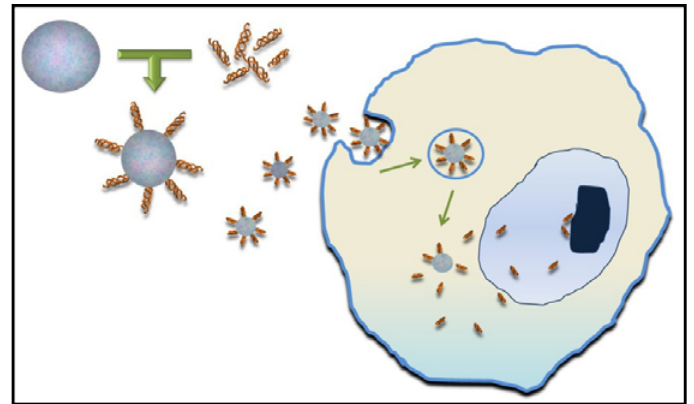
Figure 4. Synthetic nanoparticles are able to conjugate peptides, growth factors, nitric oxide or other molecules onto the particle surface and act as delivery